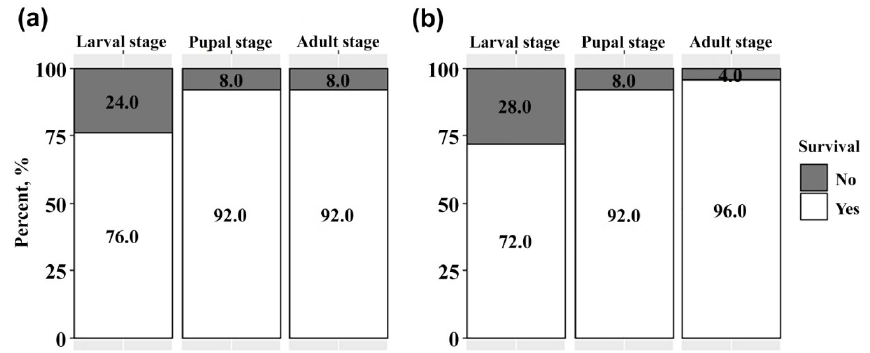
Figure 3. Mortality and survival of mosquitoes at different stages of the life cycle in control ( a ) and experimental conditions ( b ). Table 1. Average body weight of mosquitoes at different life stages in control and experimental conditions (mean ± standard deviation).